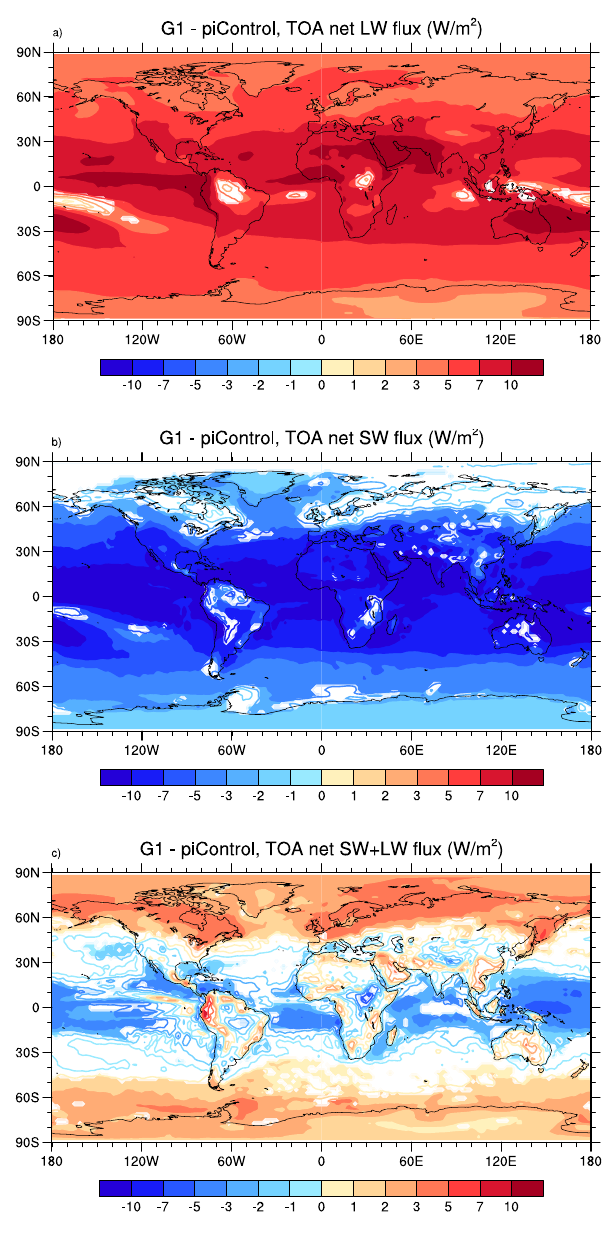
Fig. 1. Differences in TOA (top-of-atmosphere) net downward ra- diation fluxes between the simulations G1 and piControl in Wm − 2 , averaged over the four ESMs. Top panel: longwave (terrestrial), middle panel: shortwave (solar), bottom panel sum of long and short wave. In regions with filled color shading all models agree in the sign of the response. The value represented by the contours is given by the upper edge of the respective range in the color bar, i.e. the zero line is colored light